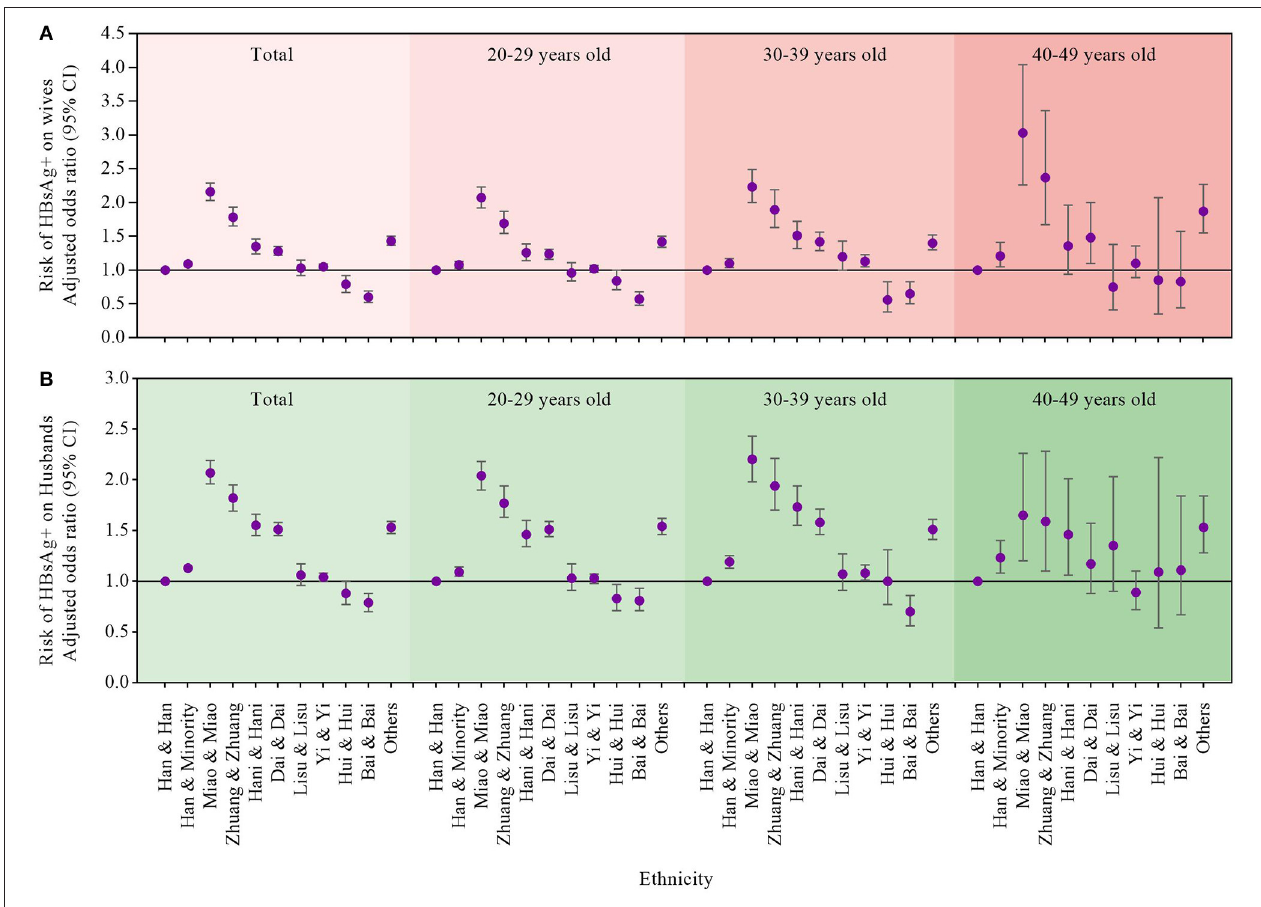
FIGURE 3 | Multivariate analyses of the association (A) between ethnicity and HBsAg status of wives (B) between ethnicity and HBsAg status of Husbands. Han and Han served as the reference group. Multivariate analyses were adjusted by age group, education, occupation, socioeconomic status and check year of the couples, and HBV status of (A) husbands/ (B)